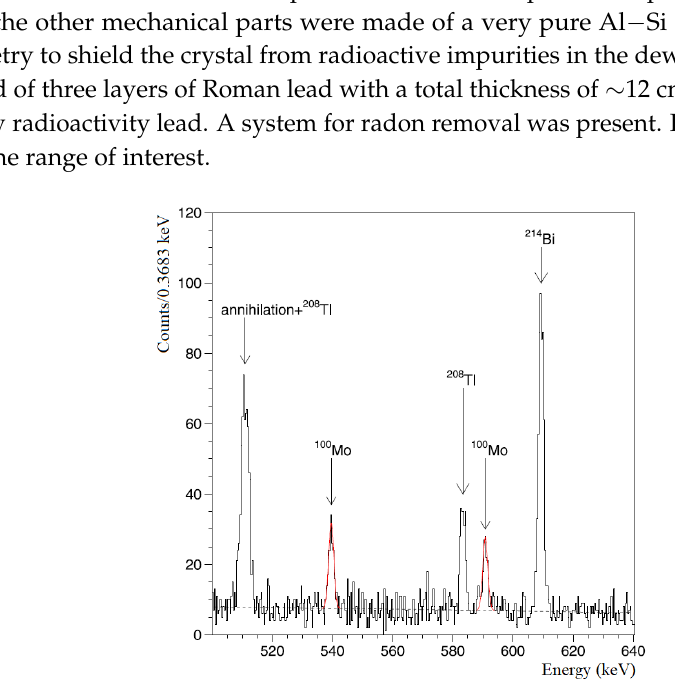
Figure 6. Energy spectrum in the range 500 − 640 keV obtained by the 2014 NEMO-3 collaboration experiment (reprinted from Reference [21] with permission from Elsevier). The dashed line is the estimated continuous background and colored (on-line) lines are the fitted peaks at 539.5 and 590.8 keV. Both peaks at 539.5 keV and 590.8 keV are clearly visible, and the calculated area are ( 129 ± 14 ) counts and ( 110 ± 13 ) counts, respectively.